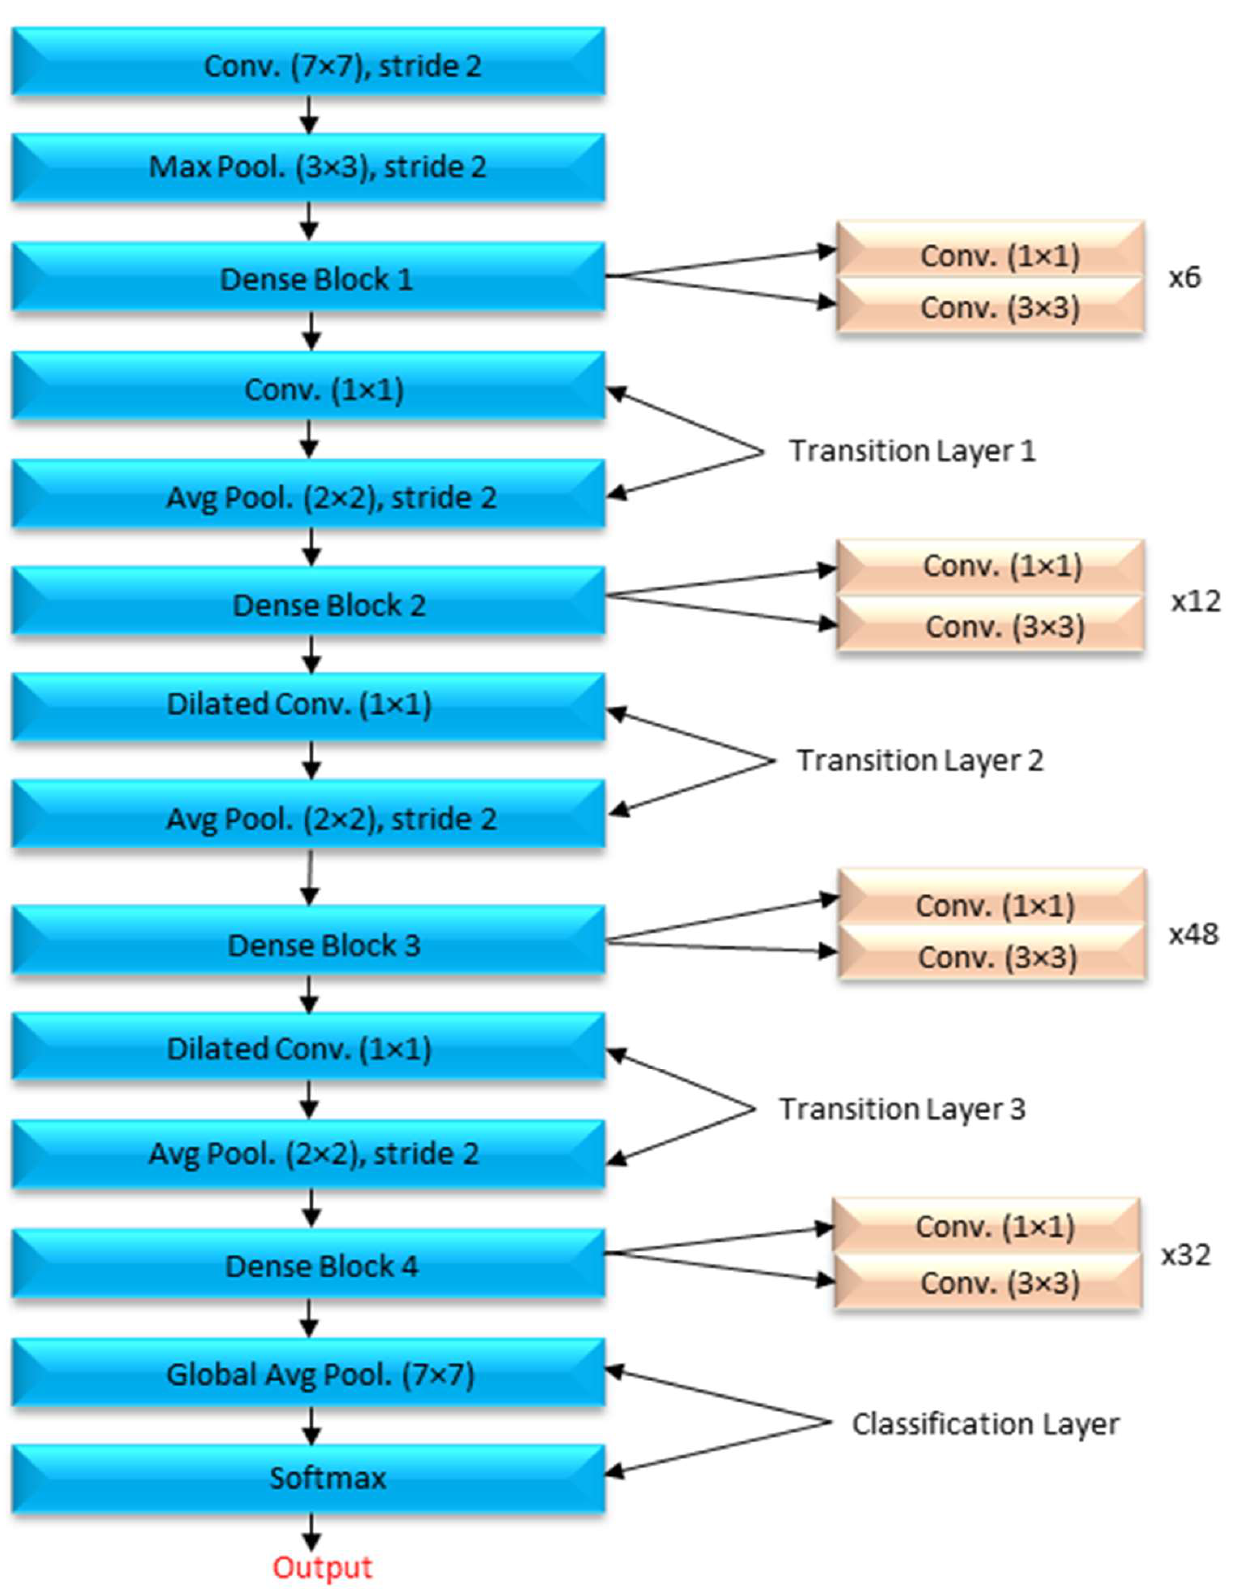
Figure 7. The internal process of the proposed improved U-Net model.